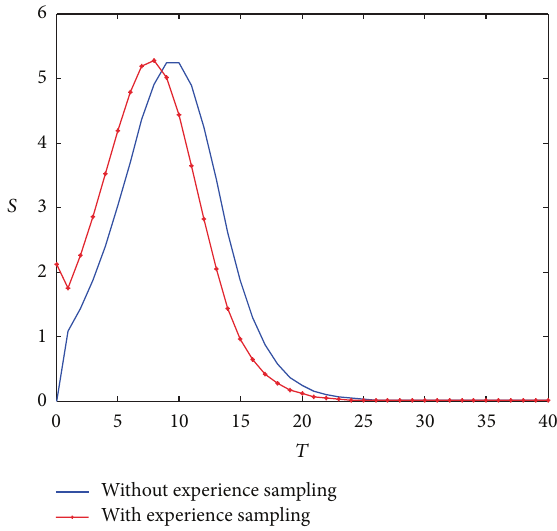
Figure 2: Impact of experience sampling on the sales curve.